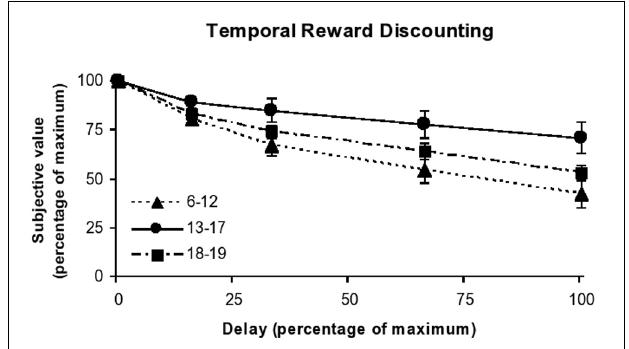
FIGURE 2 | Temporal reward discounting functions for children, adolescents, and young adults.